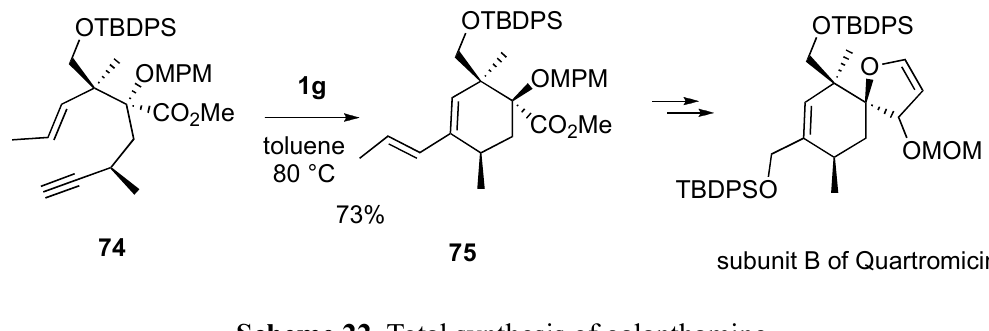
Scheme 21. Synthesis of subunit of quartromicin.